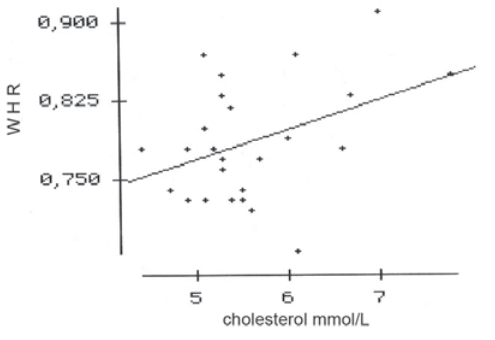
FIGURE 1. Correlation between cholesterol concentration and WHR in post-menopausal women.